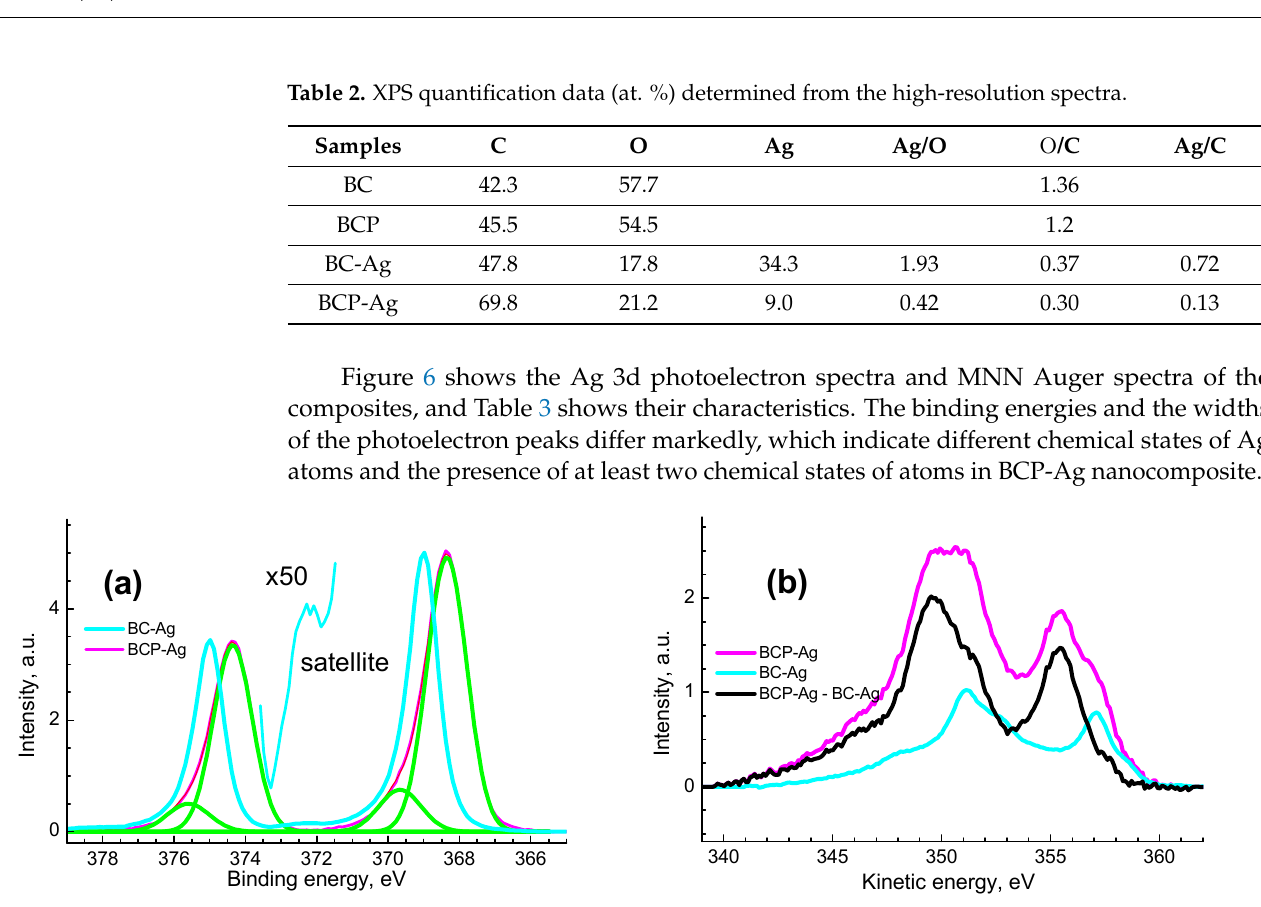
Figure 6. Ag 3d photoelectron spectra ( a ) and MNN Auger spectra ( b ) for BC-Ag and BCP-Ag nanocomposites. Table 3. Characteristics of photoelectron and Auger spectra for Ag and the nanocomposite: binding energies (E b ), spin-orbit splitting (SOS), kinetic energies (E k ) and Auger parameters.